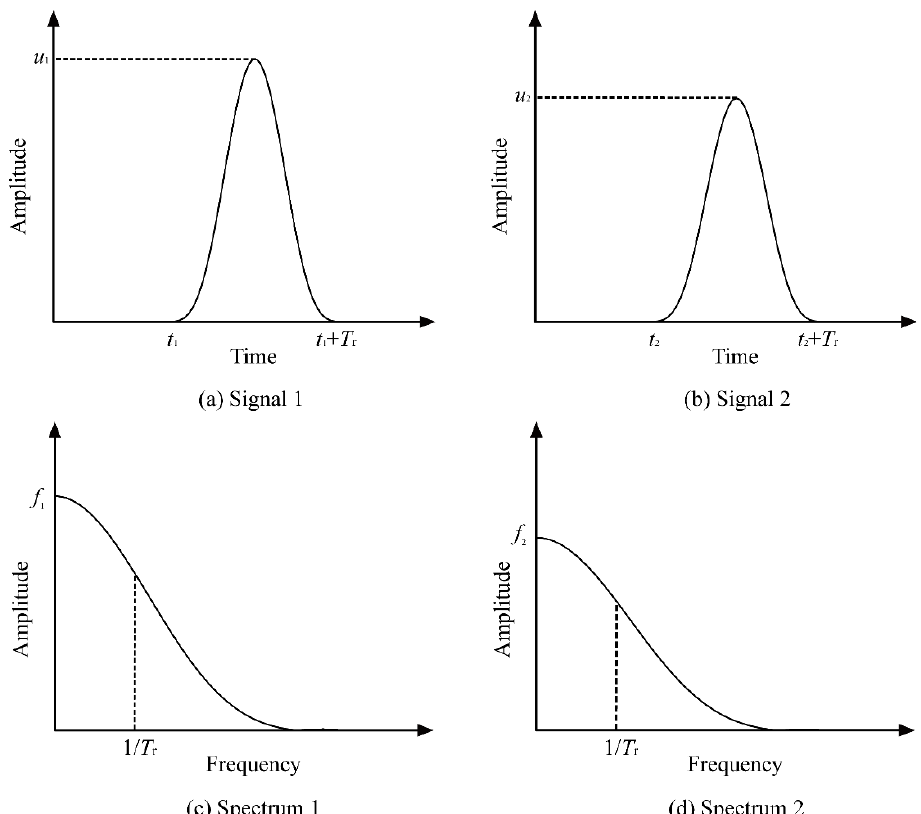
Figure 3. Two signals and corresponding frequency spectra.